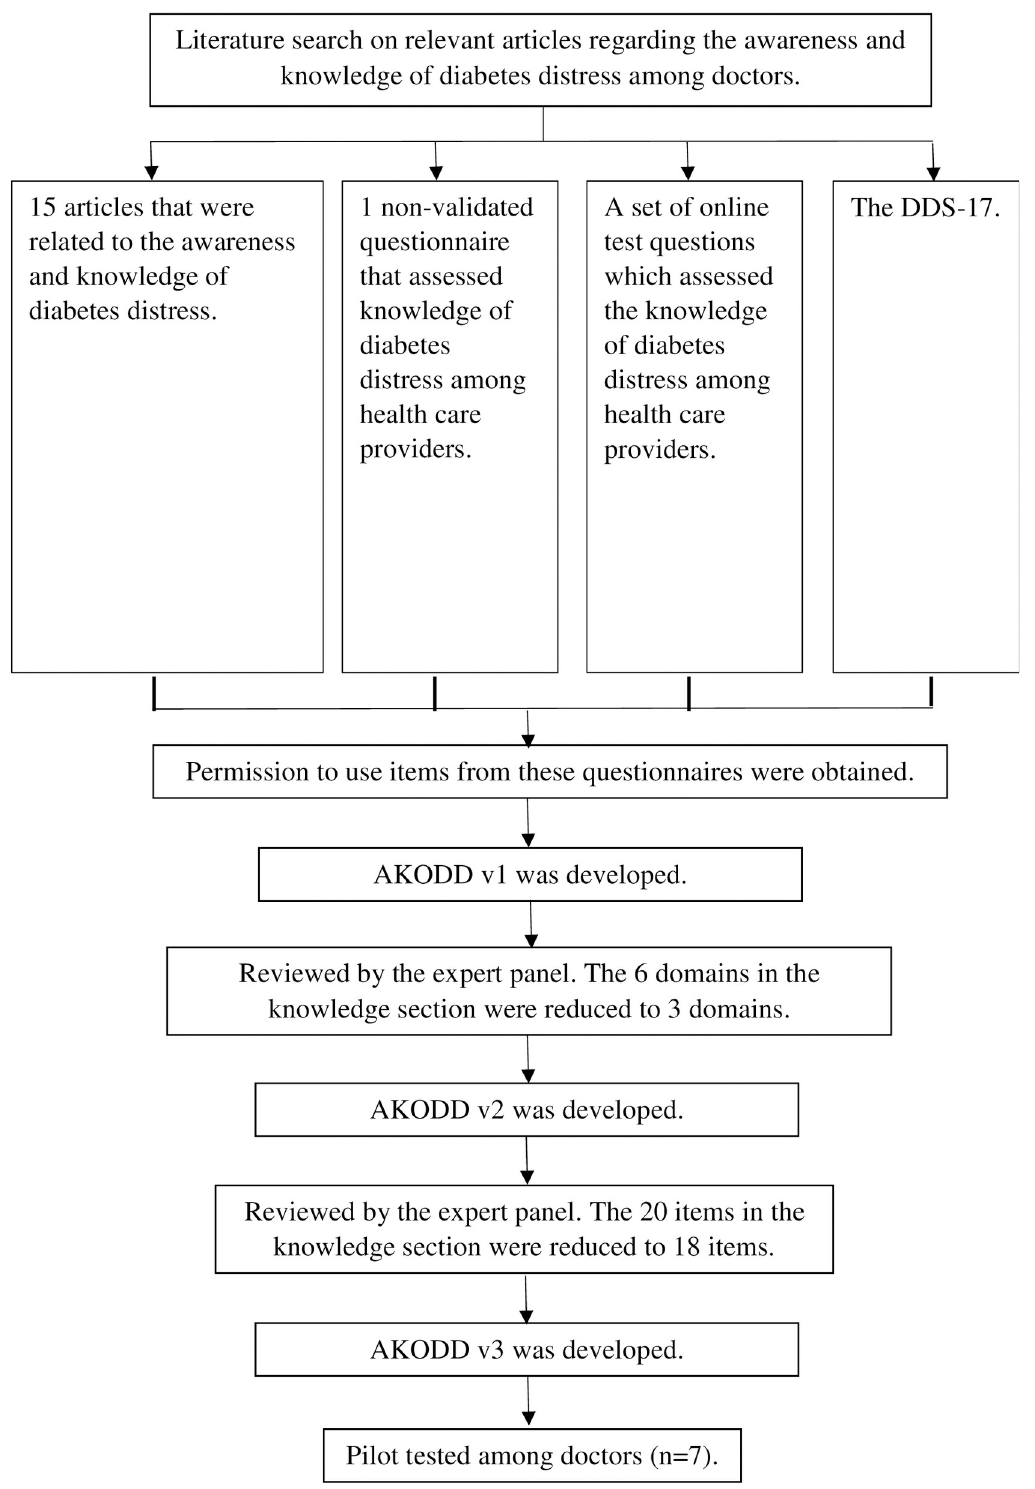
Fig 1. Development of the awareness and knowledge of diabetes distress (AKODD) questionnaire.